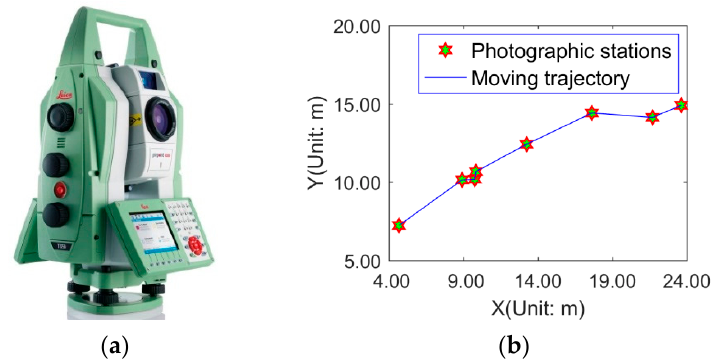
Figure 13. ( a ) Shows the Leica TS50 high-precision total station measurement system. The source of the photo of the Leica TS50 was taken from the official Leica product manual ( b ) shows the moving trajectory and photographic positions of the planetary rover during the test.